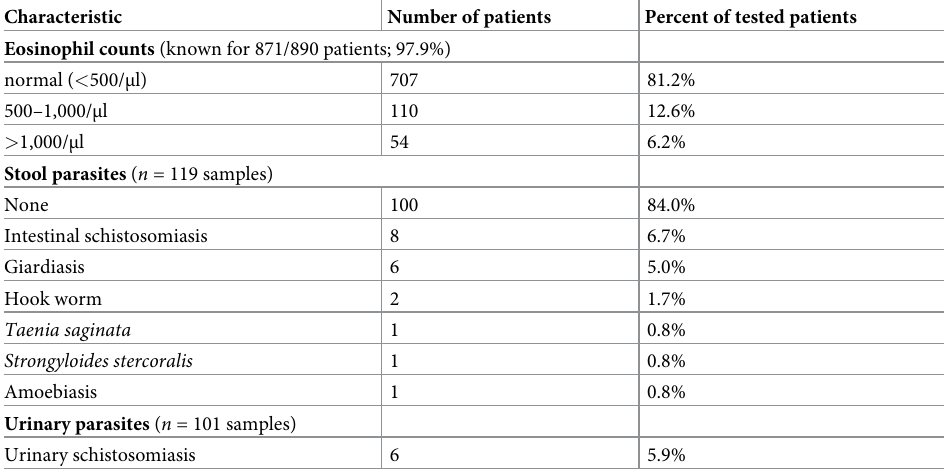
Table 2. Screening of parasite infection. Characteristic Number of patients Percent of tested patients Eosinophil counts (known for 871/890 patients;